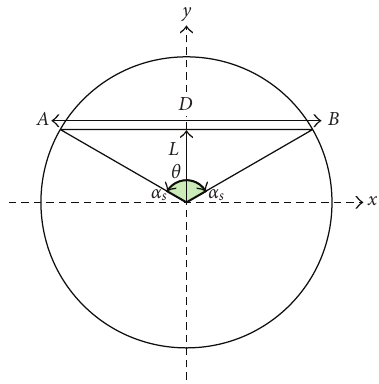
Figure 2: Entrance and exit points after rotation to achieve horizontal traveling path.